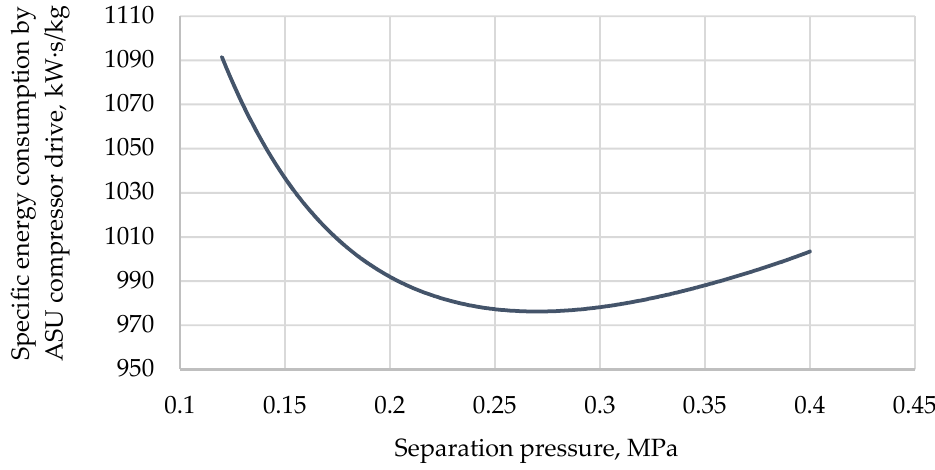
Figure 8. Dependence of the specific energy consumption of an ASU compressor drive with a single-stage intercooled compressor.